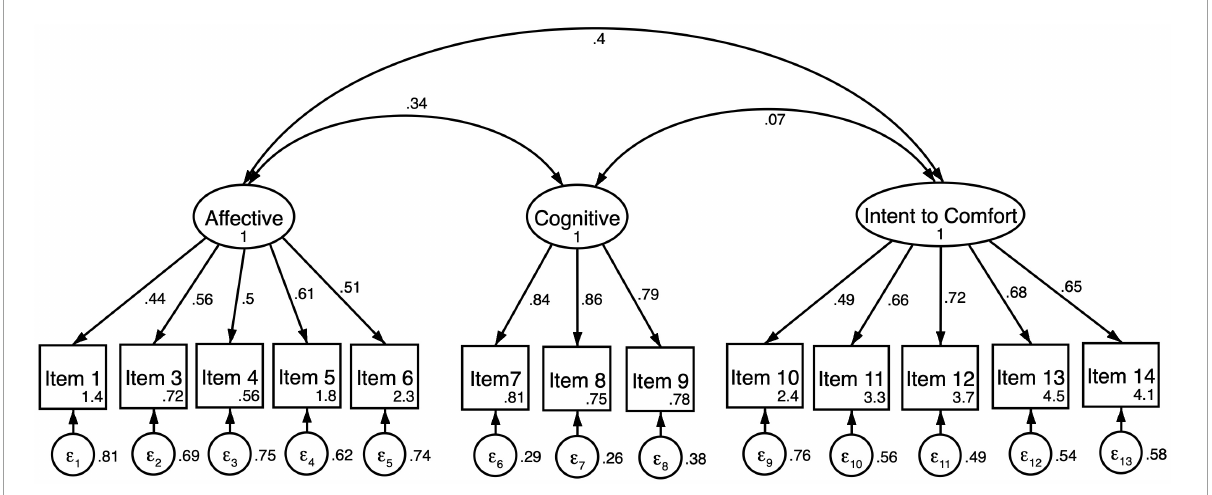
FIGURE1 Three-factor confirmatory factor analysis of the EmQue-CA (13 items; N = 290). All factor loadings on latent factors significant at the p < 0.001 level. Values inside item boxes represent intercepts.